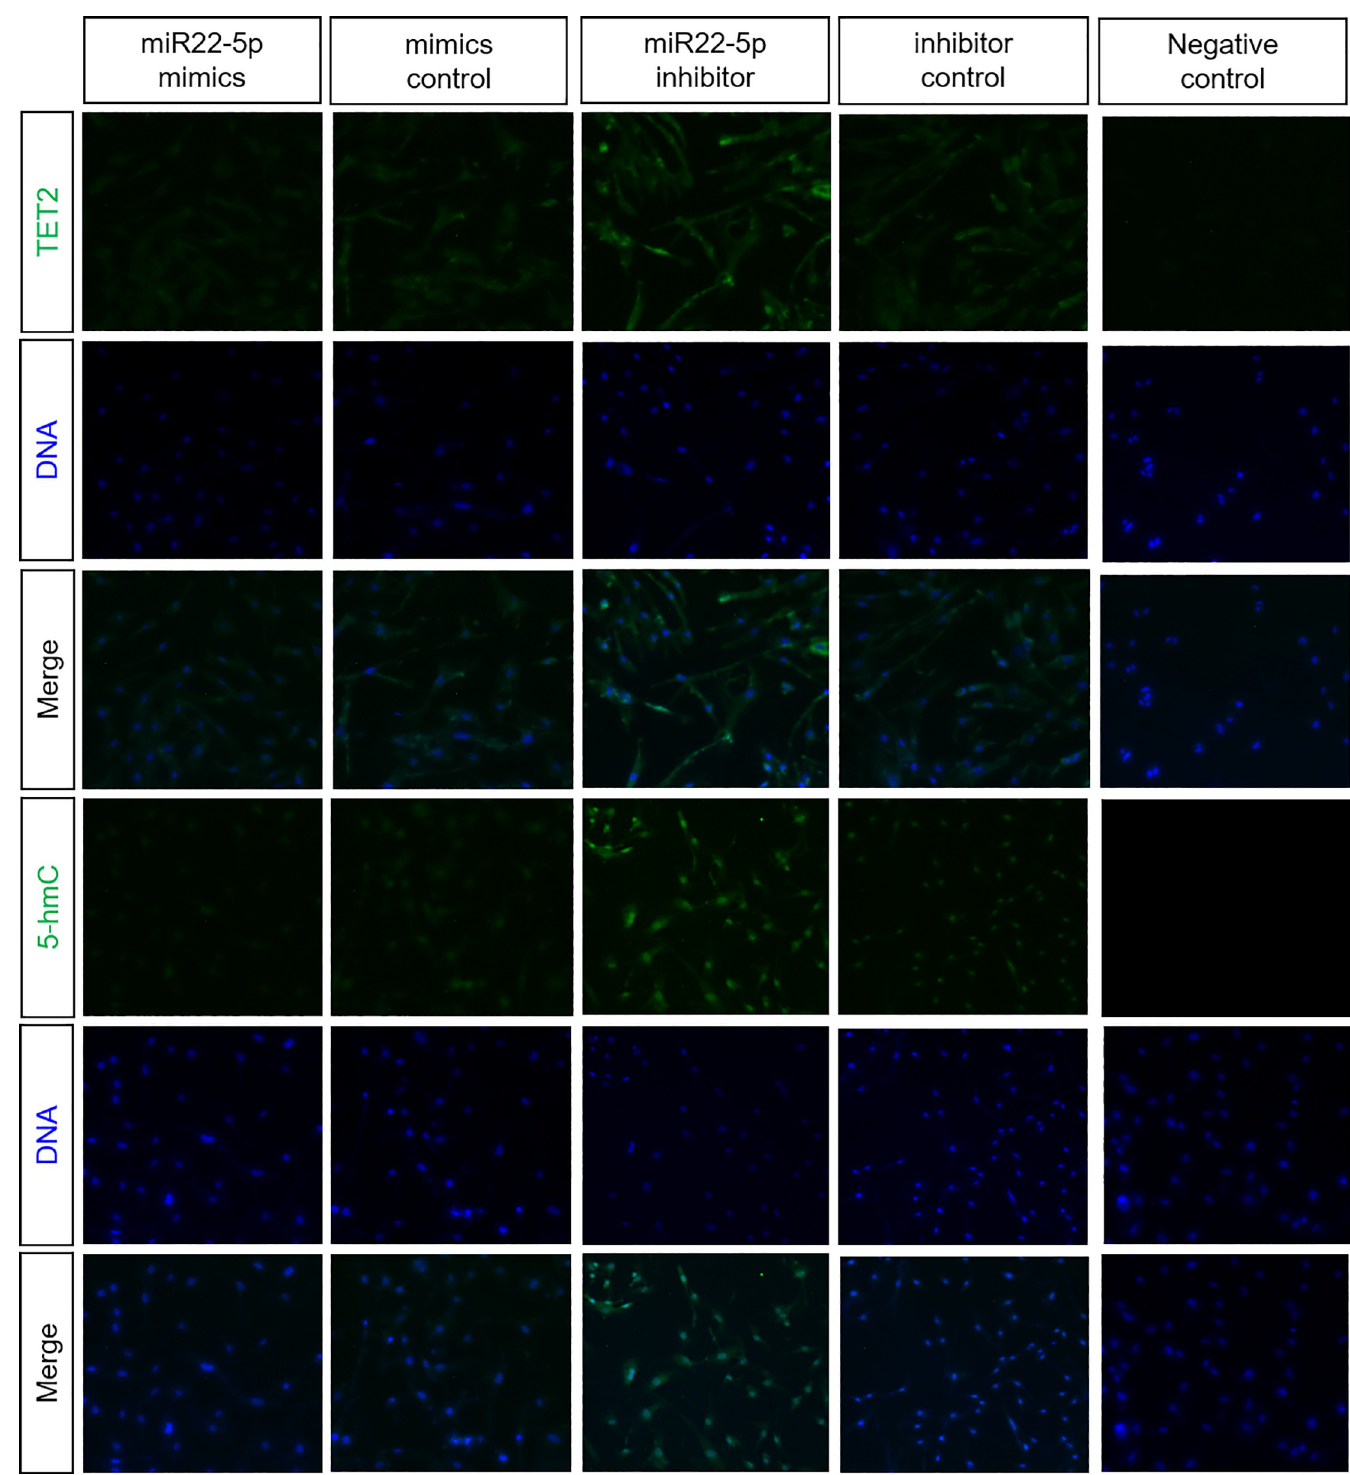
Fig 3. Immunofluorescence expression of TET2 and 5-hmC in ESCs following treatment with miR22-5p mimics and inhibitor.